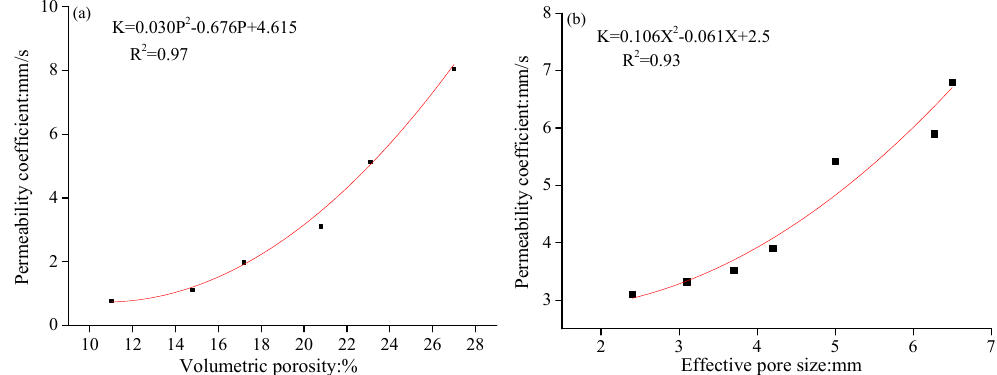
Figure 11. Permeability coefficient of pervious concrete. ( a ) The relationship between the permeability coefficient and volumetric porosity of pervious concrete with aggregate sizes of 4.75–9.5 mm; ( b ) the relationship between the permeability coefficient and effective pore size of pervious concrete with 21% design porosity.